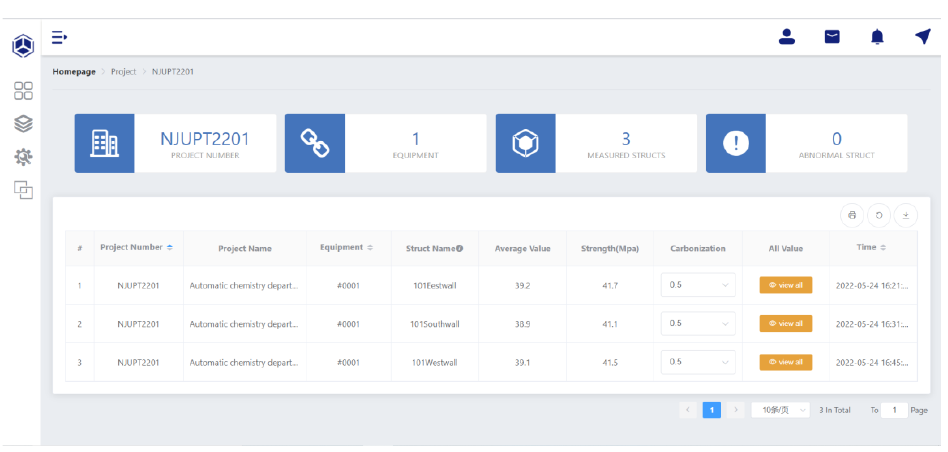
Figure 7. The webpage of the cloud information management platform.